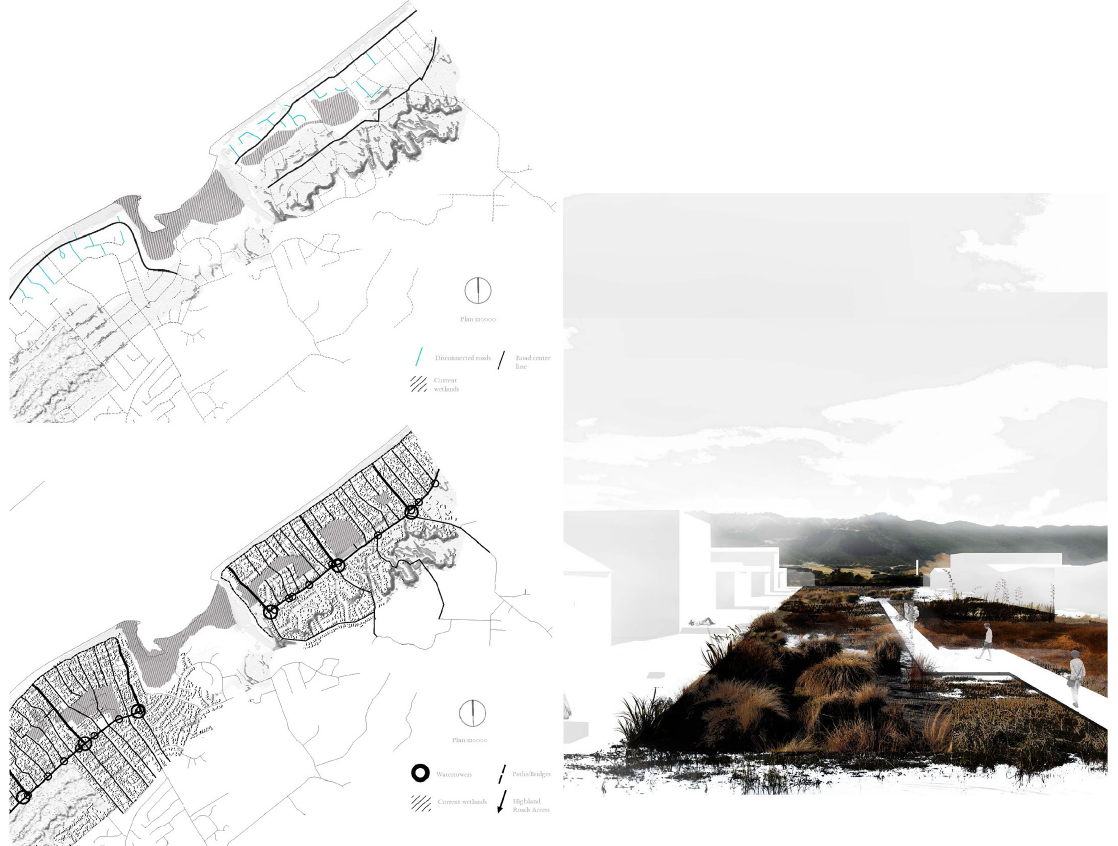
Figure 6. High Ground, Low Ground , a speculative design by Caitlin Wallis. Plan of existing streets parallel to the coast (top left); and proposed plan of perpendicular movement lines, designed to avoid removal of any houses (bottom left); proposed image of common path through backyards to high ground in background (right). Source: Caitlin Wallis .